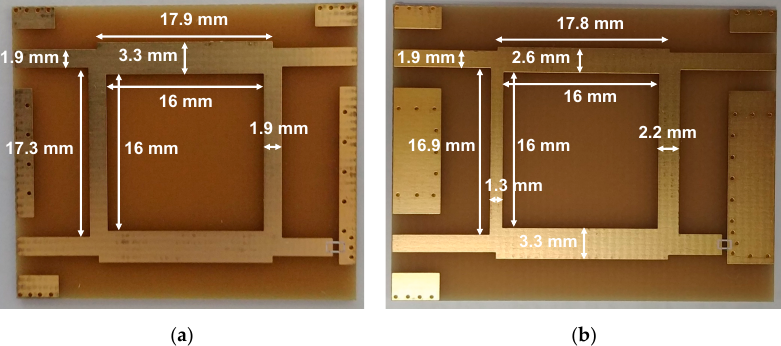
Figure 4. 2.45 GHz quasi-circulators fabricated on an FR4 PCB: ( a ) the conventional circulator using a symmetrical branch-line coupler; ( b ) the proposed circulator using an asymmetrical branch-line coupler.